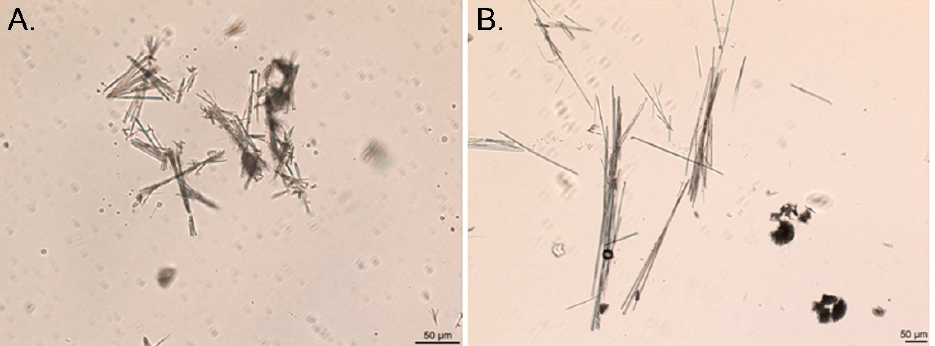
Figure 11. Optic microphotographs of the crystals precipitated from warfarin sodium amorphous buffer solutions at ( A ) pH = 3; and ( B ) pH = 6.